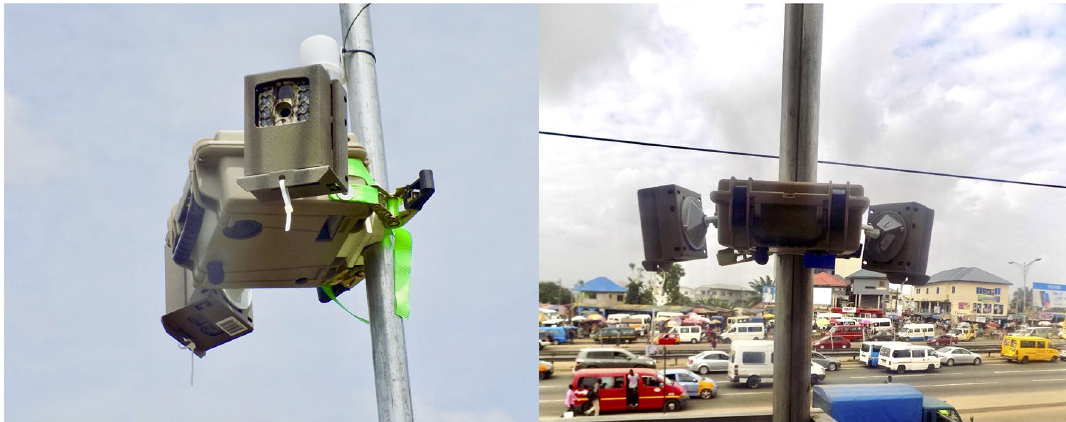
Figure 1. Examples of cameras used for image capture and their installation at measurement